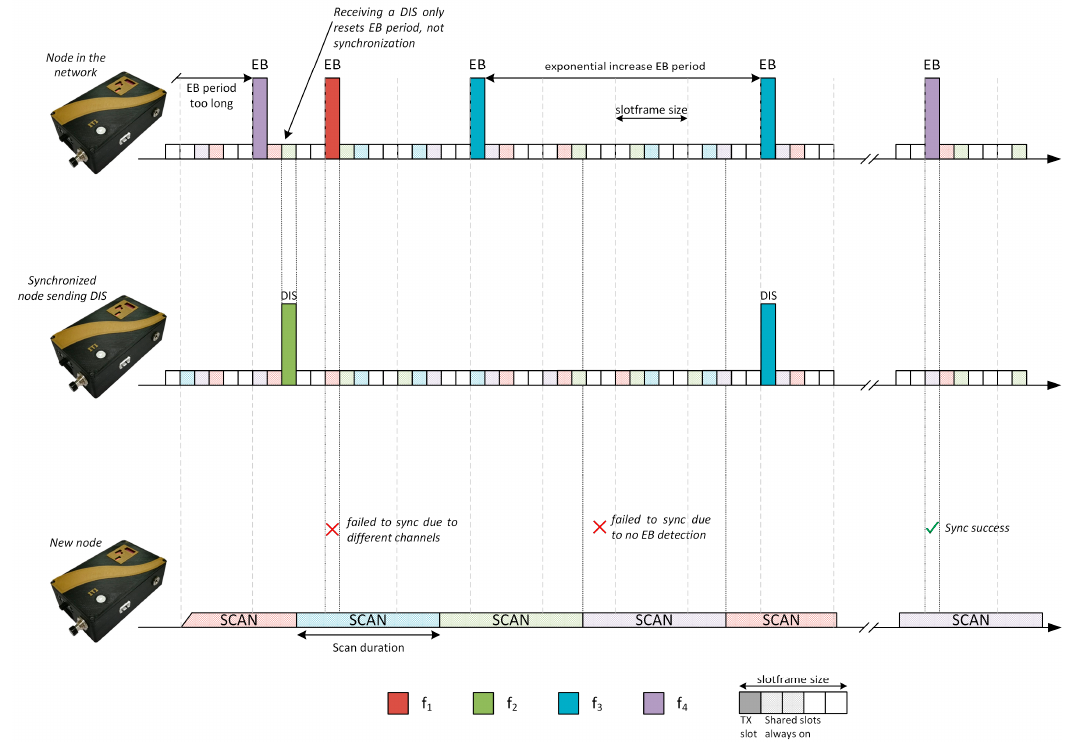
Figure 3. Routing Protocol for Low-Power and Lossy Networks (RPL) Trickle Timer evolution over time.